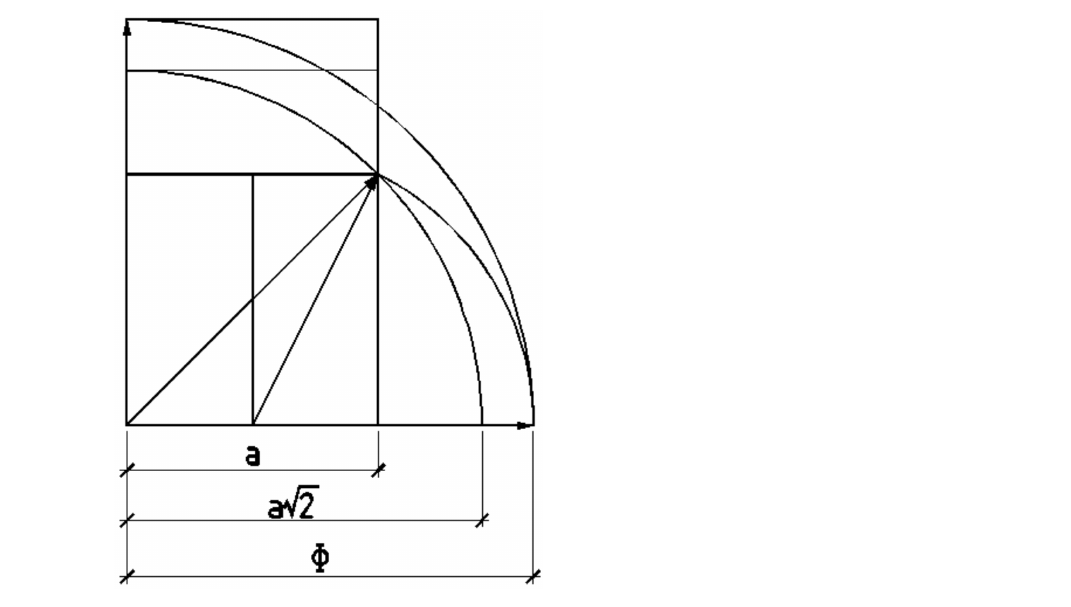
Figure 17. Difference between the Seokguram temple proportion and the golden ratio: one uses the diagonal of the square instead of the diagonal of a half square.